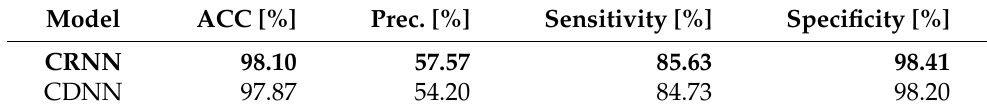
Table 9. Results of additional testing on the new annotated audio